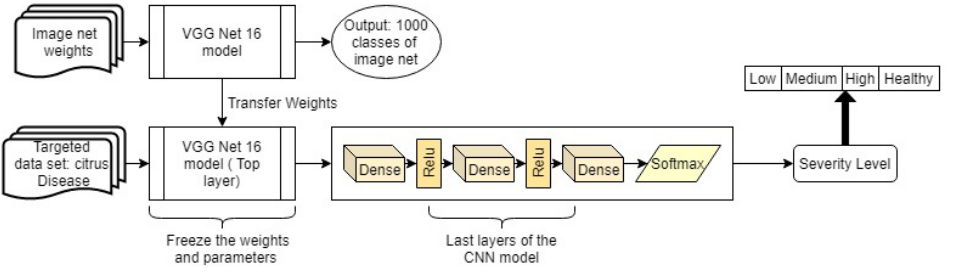
Figure 7. Proposed CNN model with transfer